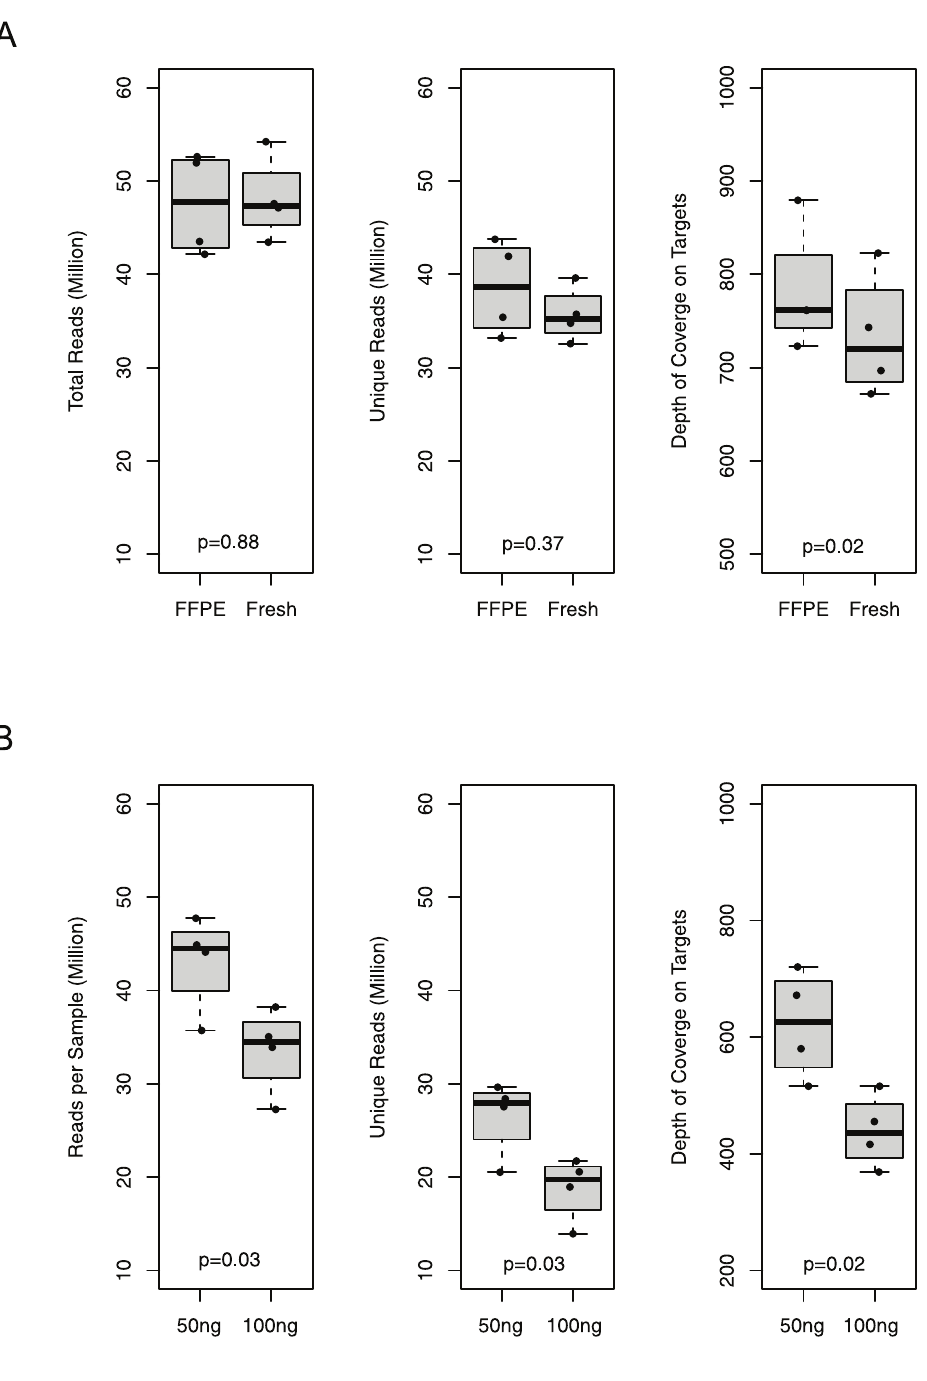
Fig 2. Sequencing performance of DNA source and input amount. A) Comparison of equal amount of input DNA from fresh-frozen tissue vs. from formalin-fixed paraffin-embedded (FFPE) materials. B) Comparison of 50ng without size selection vs 100ng with size selection input DNA in library